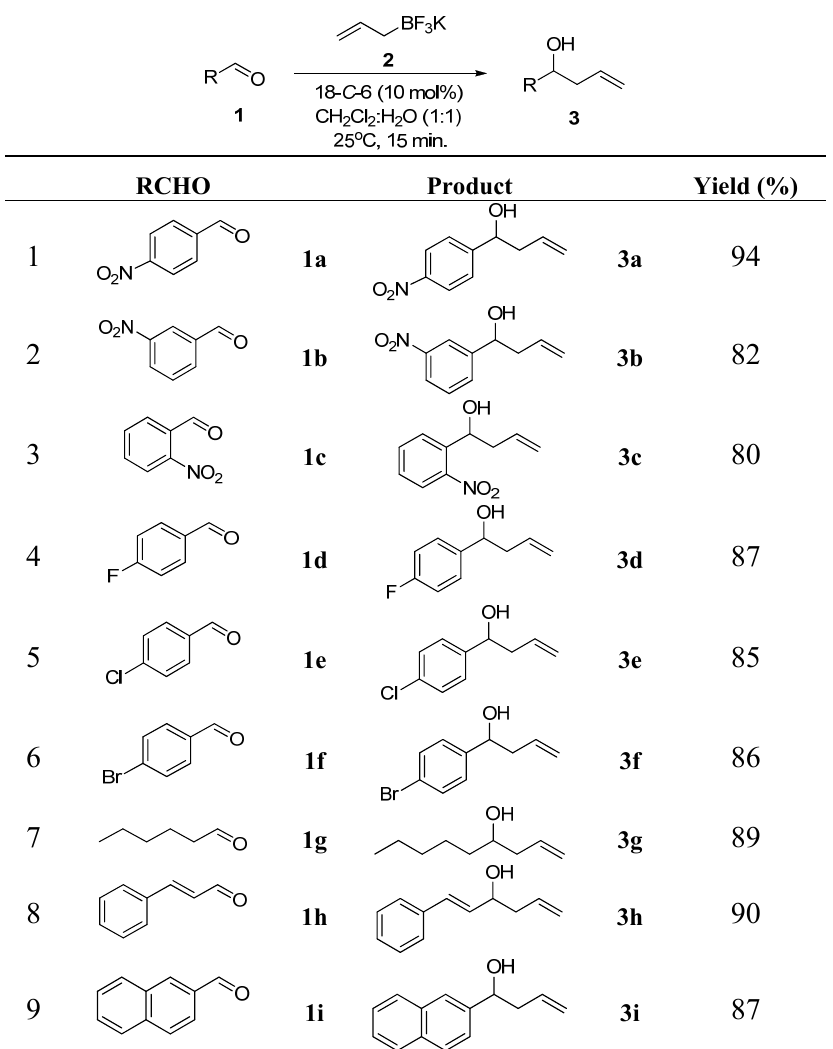
Table 2. Allylation of aldehydes 1 with potassium allyl trifluoroborate 2 catalyzed by 18- C -6 (10